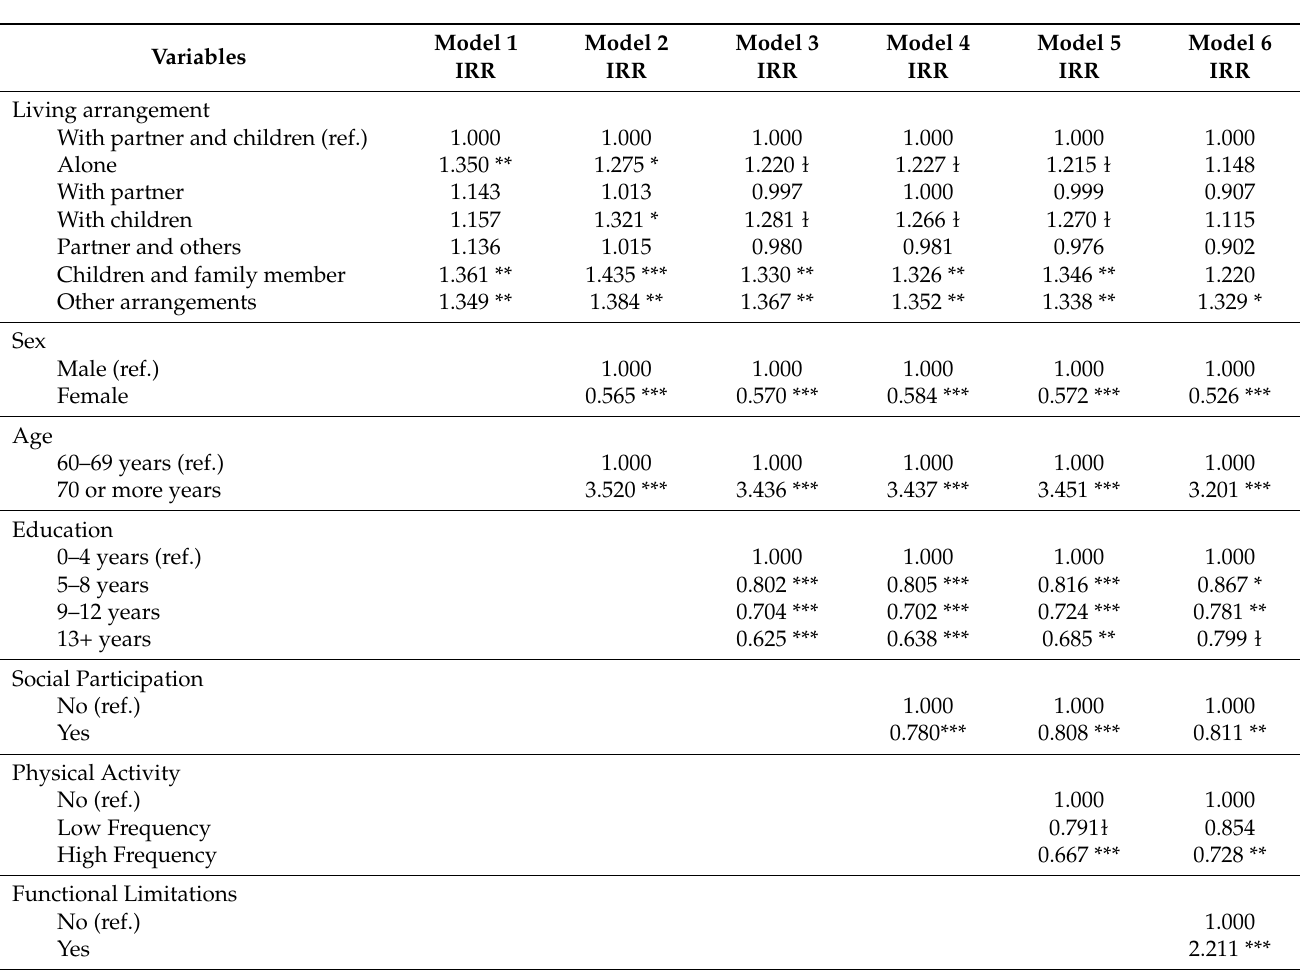
Table 3. Rate ratios for the association between living arrangement and mortality in older